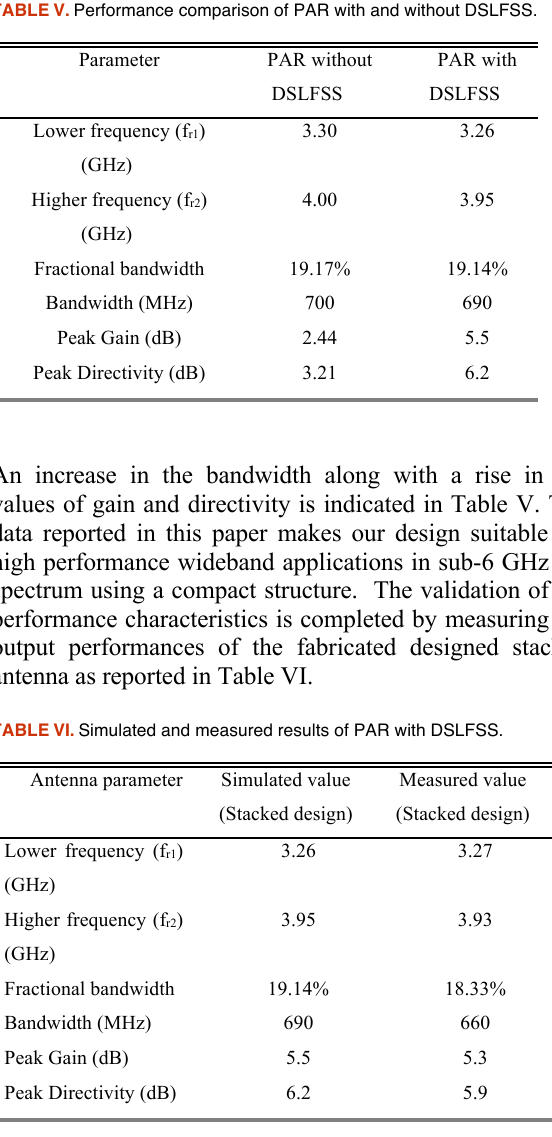
FIGURE 9: Radiation patterns of the PAR with and without DSLFSS superstrate, (a) E-plane, and (b) H-plane.